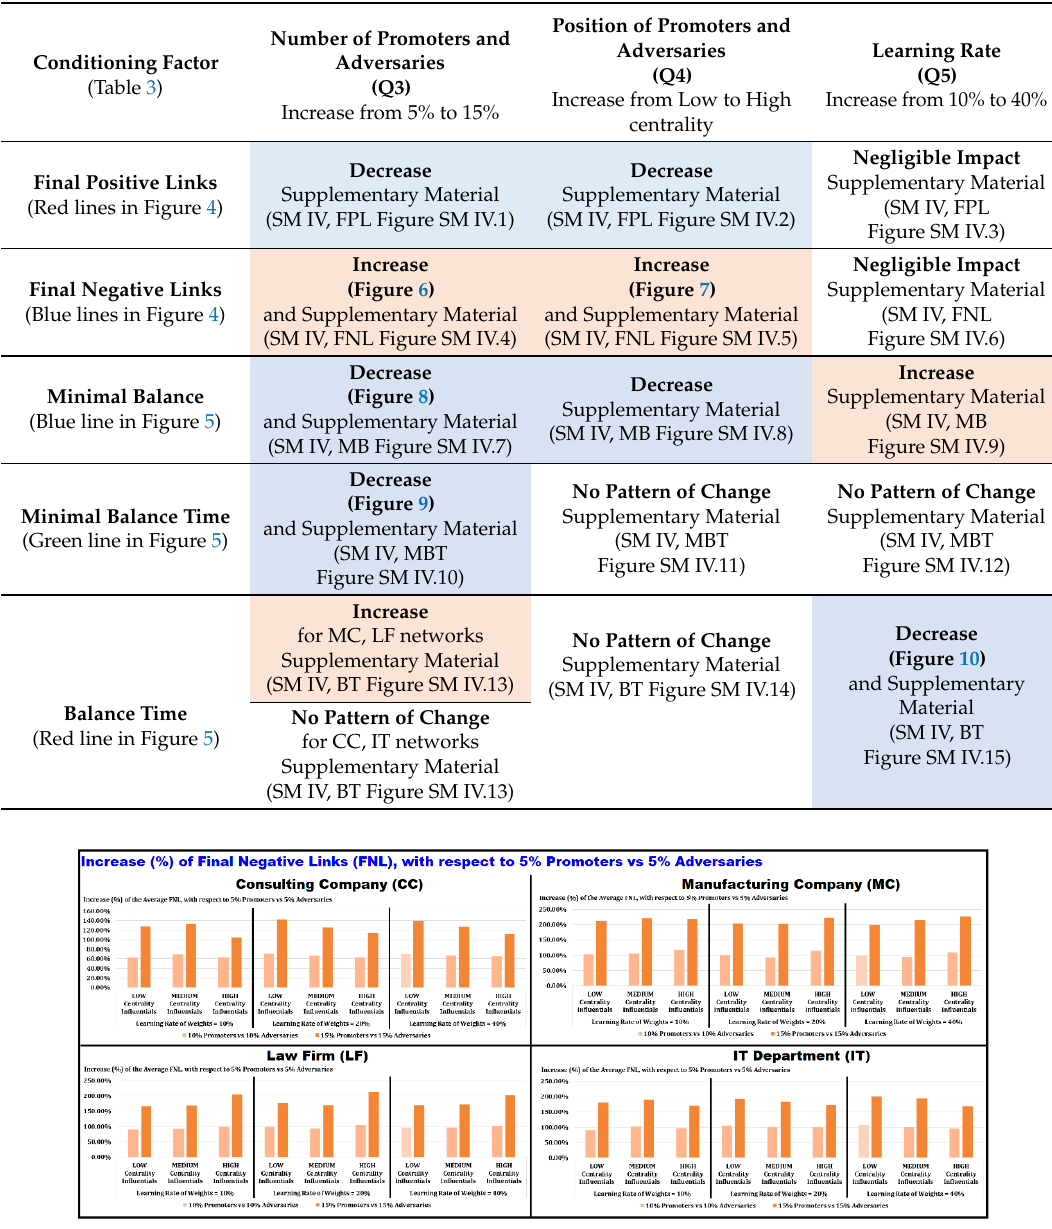
Figure 7. Relative Increase (%) of Final Negative Links (blue horizontal lines in Figure 4) for the selected values of learning rate and number of promoters and adversaries (Table 3). The increase of Final Negative Links when the position of promoters and adversaries changes from low centrality to